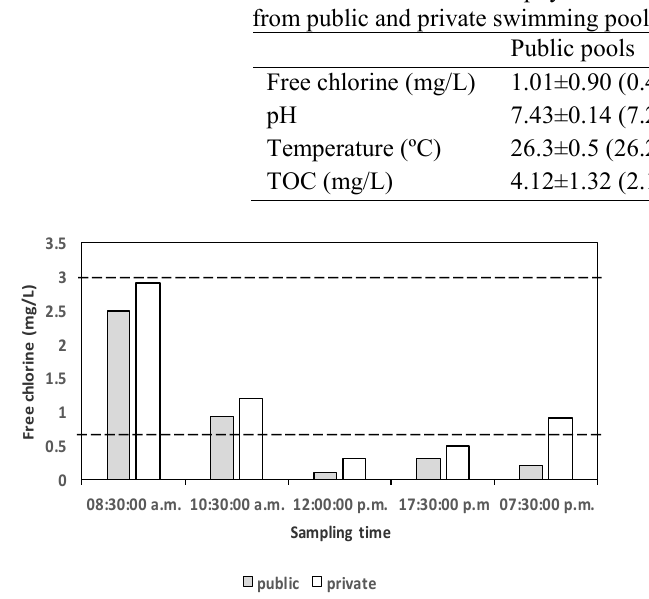
Fig. 1. Free chlorine level at different intervals in water samples from public and private swimming pools (horizontal dashes indicate the free chlorine range based on Iranian